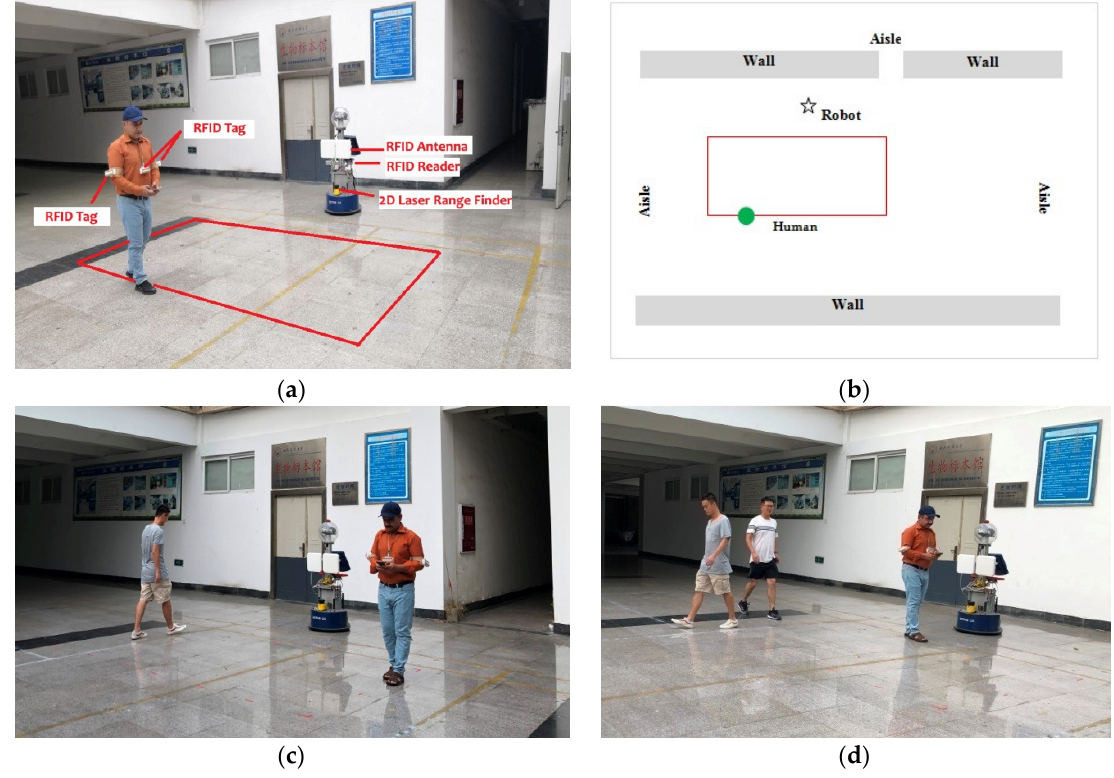
Figure 5. Robot and experiment setup. ( a )An example of a real time experiment; ( b ) conceptual view of the environment; ( c ) another human moving in the test area; ( d ) multiple humans moving in test area.